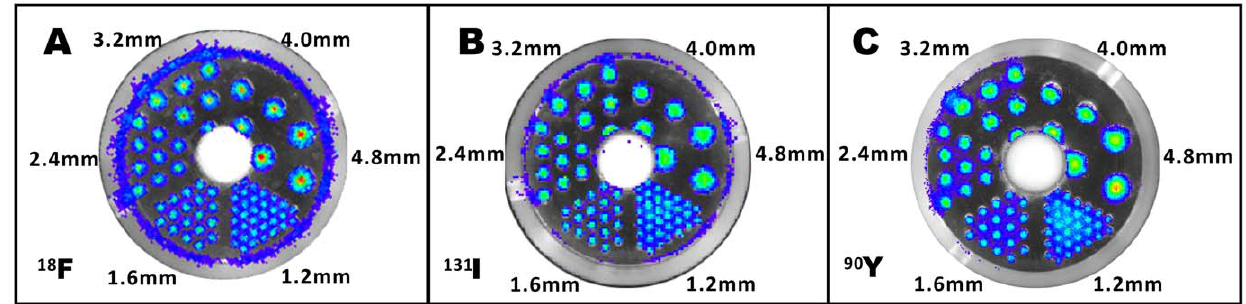
Figure 2. Phantom imaging studies with radioactive OI and PET. ( A–C ) Radioactive OI of 18 F, 131 I and 90 Y phantoms.